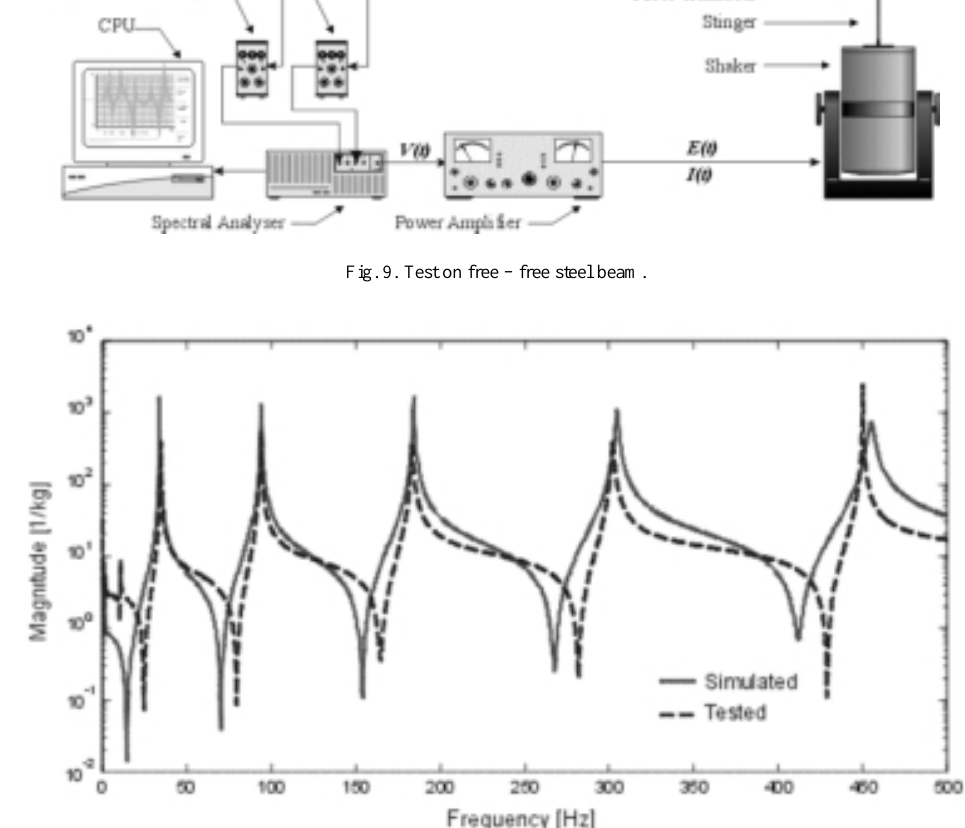
Fig. 10. Driving point